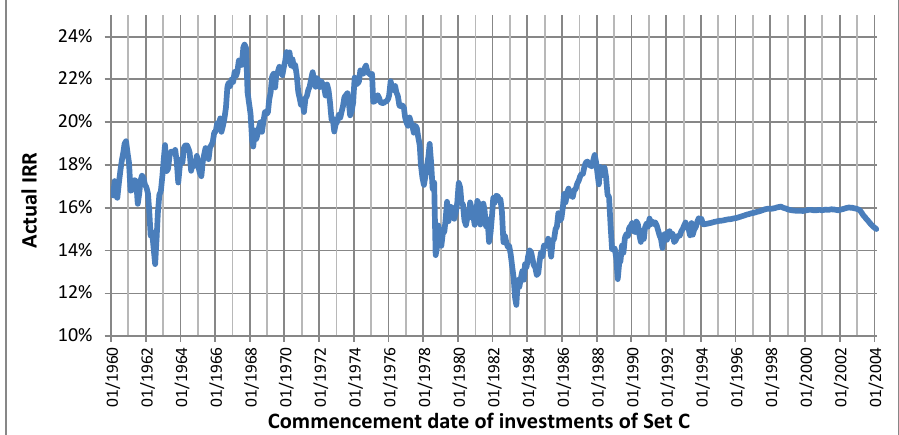
FIGURE 5: IRRs generated by the monthly investments of Set C Source: Authors’ deductions